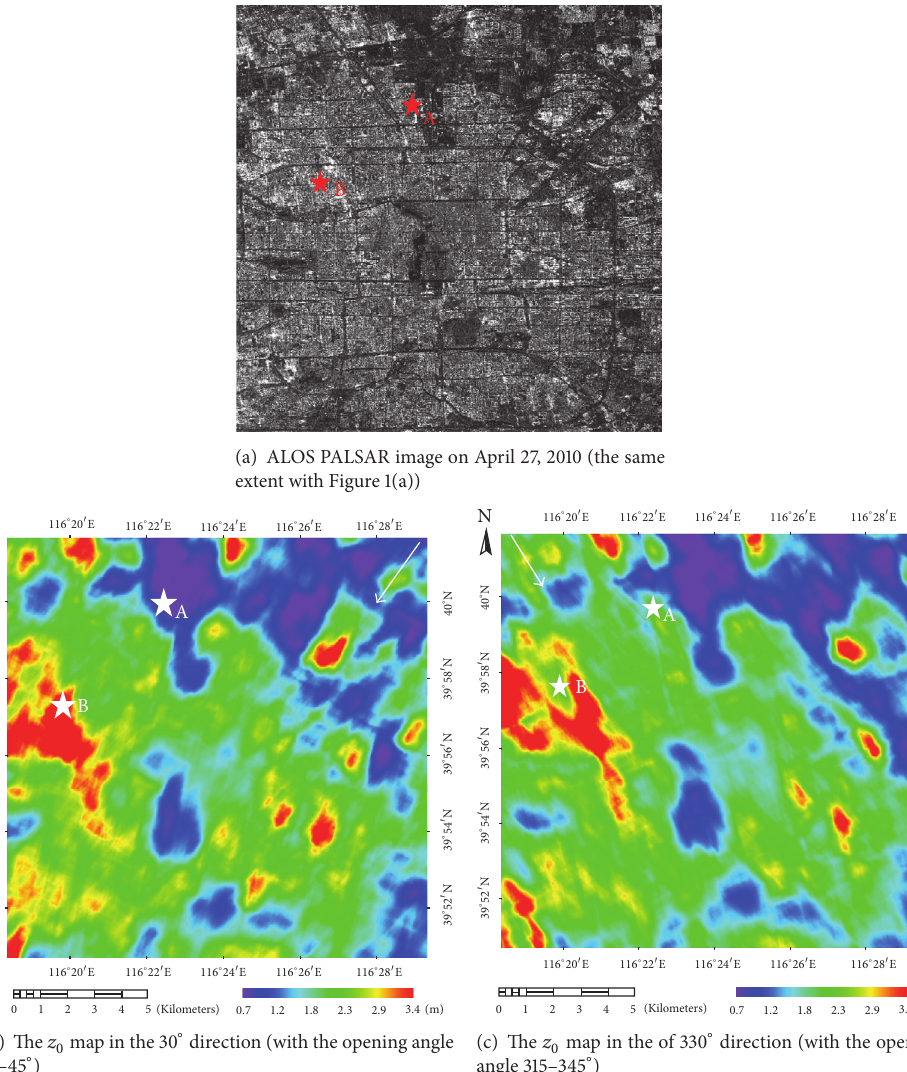
Figure 11: The ALOS PALSAR image on 27 April 2010 and the retrieved aerodynamic roughness length. (a) The ALOS PALSAR image, (b) the retrieved aerodynamic roughness length in the 30 ∘ direction, and (c) the retrieved aerodynamic roughness length in the 330 ∘ direction. The arrow indicates the wind direction, that is, the central angle of the upwind sector. Stars A and B indicate two examples of aerodynamic roughness